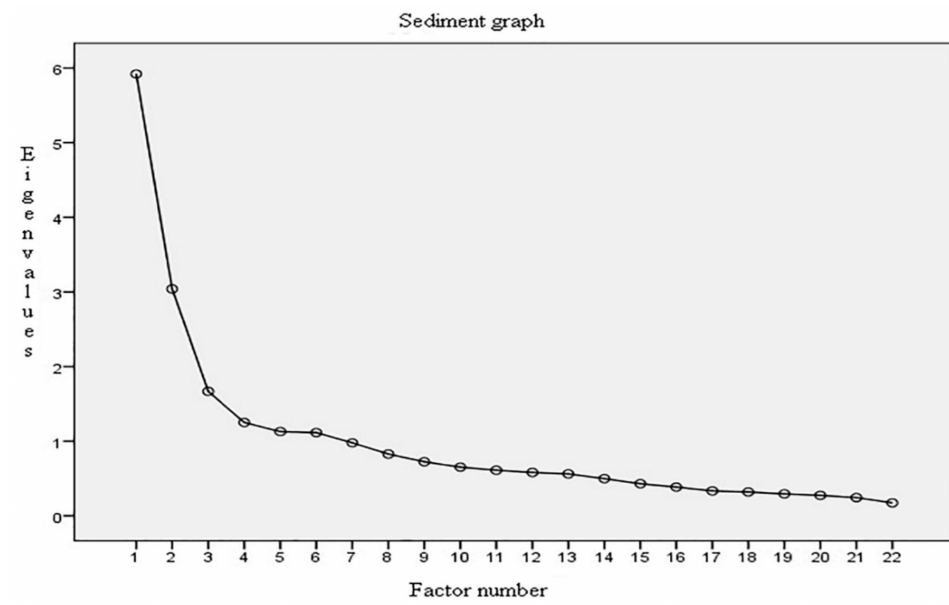
Figure 1. Scree plot of the factor solution. Table 4. Configuration